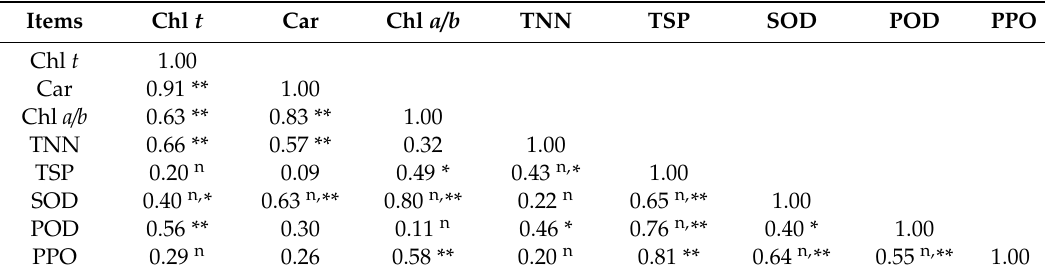
Figure 3. Changes of the superoxide dismutase (SOD) activity ( A ), peroxidase (POD) activity ( B ), and polyphenol oxidase (PPO) activity ( C ) in the six barley cultivars at different developmental stages. Data represent mean values standard deviation (SD) from three independent experiments. Bars show standard deviations of the mean. Asterisks on top of the bars indicate statistically significant differences ( ** p < 0.01). Table 4. Correlation among the Chl t , and Car content, Chl a / b ratio, TNN, and TSP content, and SOD, POD, and PPO